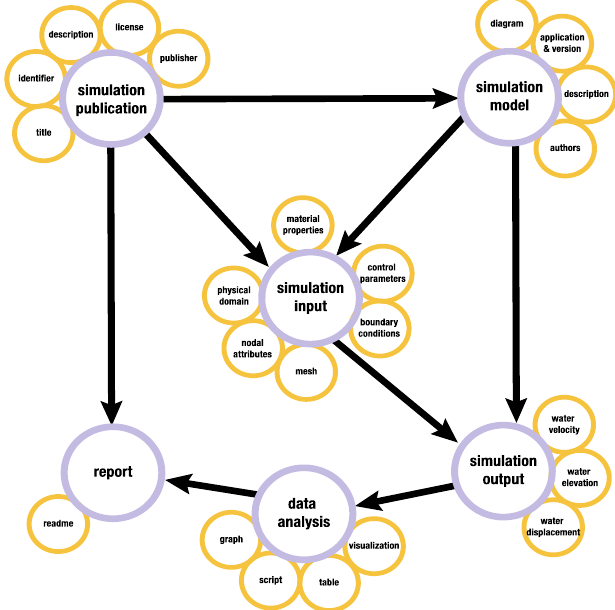
Figure 2. Data model for simulation data, with terms illustrating storm-surge.